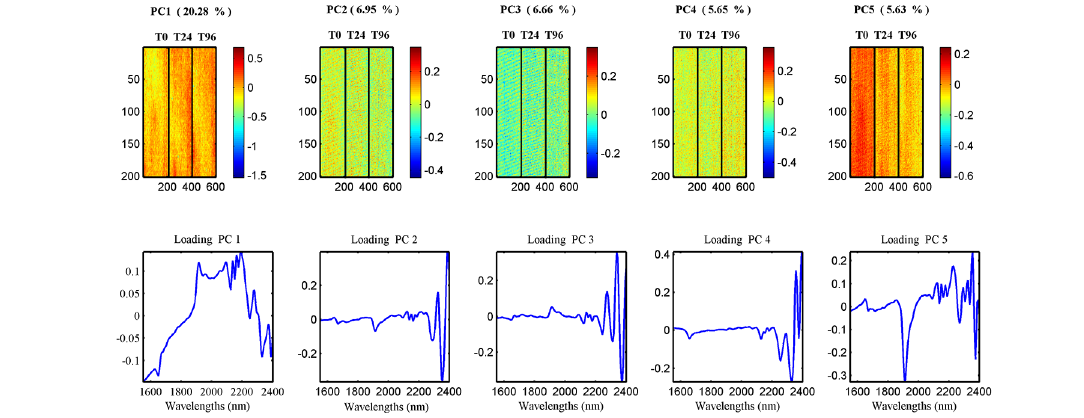
Figure 5. Scores images and loadings of the five first PCs of PET sample after exposure (T0, T24 and T96) to NaOH solution (spectral range: SR2). T0, T24 and T96 correspond to exposure times (0 hours, 24 hours and 96 hours), respectively. The axes number refers the spatial dimension (pixels) of each image (200 x 200 pixels) for each time exposure.